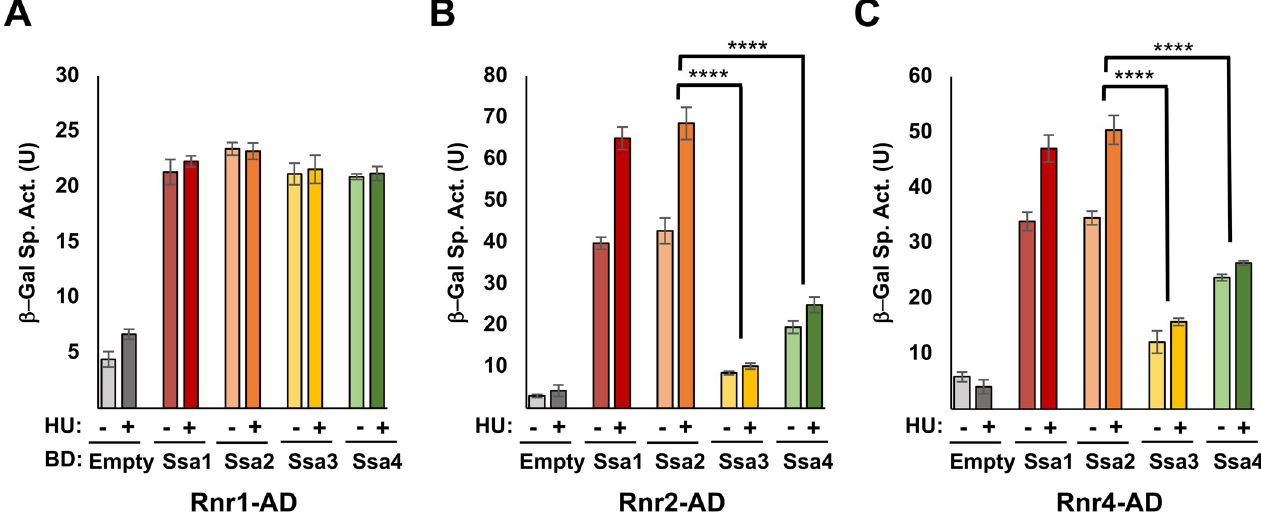
Fig 4. RNR small subunits display binding selectivity for Ssa paralogs. PJ694a/ α cells were transformed with the appropriate AD-RNR and BD-Ssa fusions. Cells were grown in selective media to the mid-log phase at which point protein was extracted and analyzed for β -galactosidase activity. Each value represents the mean and standard deviation (error bar) from three independent transformants. Statistical significance between samples was calculated as above. � , P � 0.05 �� , P � 0.01; ��� , P � 0.001; ���� , P � 0.0001 compared to indicated strains.